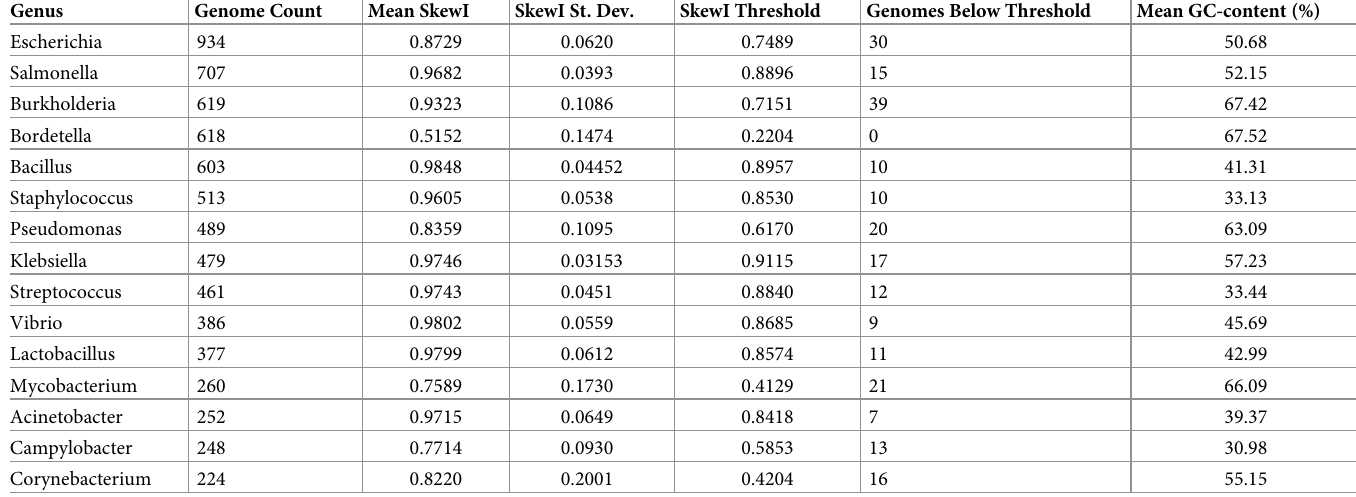
Table 1. Average SkewI values for the 12 bacterial genera with the largest number of complete genomes. The threshold was set at 2 standard deviations below the mean. Genus Genome